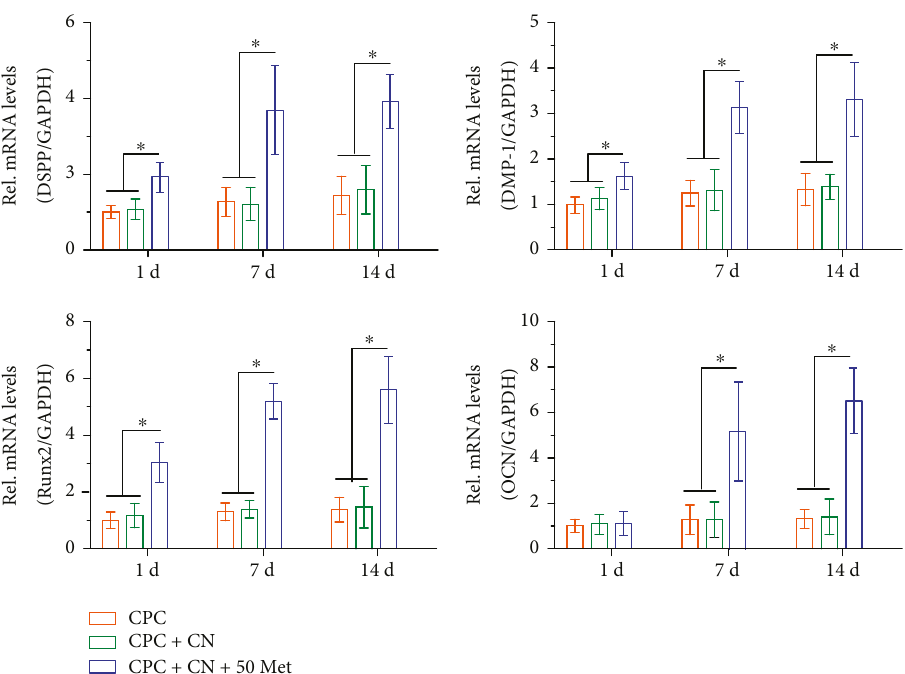
Figure 5: DPC odontogenic di ff erentiation on CPC control, CPC +CN control, and CPC +CN +50Met. The mRNA expression levels of DSPP, DMP-1, Runx2, and OCN were determined using qRT-PCR. The mRNA expression levels of DSPP, DMP-1, Runx2, and OCN signi fi cantly increased in the CPC +CN + 50Met compared with the CPC control and CPC+ CN control ( ∗ P < 0 05 ). GAPDH was used as an internal control. Data represent mean ± SD of three independent experiments with triplicates.